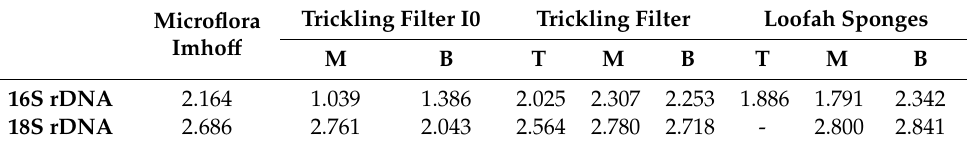
Figure 3. The denaturing gradient gel electrophoresis (DGGE) profiles that were obtained at different stages of the experiment using the amplified ( a ) bacterial V3-V5 regions of the 16S rRNA gene and ( b ) the fungal ITS1/2 regions of the 18S rRNA gene. The lines that are marked as Microflora Imhoff contain the sequences that were obtained from the middle part of TF-I0 before the exposure to naproxen; Trickling filter I0 after the exposure to naproxen; Trickling filter and loofah sponges after the complete biodegradation of naproxen; B1(2015b) contains the sequences that were obtained from pure cultures of B1(2015b) cells. The letters T M B represent the sampling sites: T—top, M—middle and B—bottom of the TF. Table 2. Changes in the Shannon-Wiener index ( H’ ) of the bacterial (16S rDNA) and fungal (18S rDNA) communities corresponding to the denaturing gradient gel electrophoresis (DGGE) profiles that were obtained after the treatments. Columns marked as Microflora Imhoff contain the H ’ values that were calculated from the middle part of TF-I0 before the exposure to naproxen; Trickling filter I0 after the exposure to naproxen; Trickling filter and the loofah sponges after the complete biodegradation of naproxen. The letters T M B represent the sampling sites: T—top, M—middle and B—bottom of the TF.